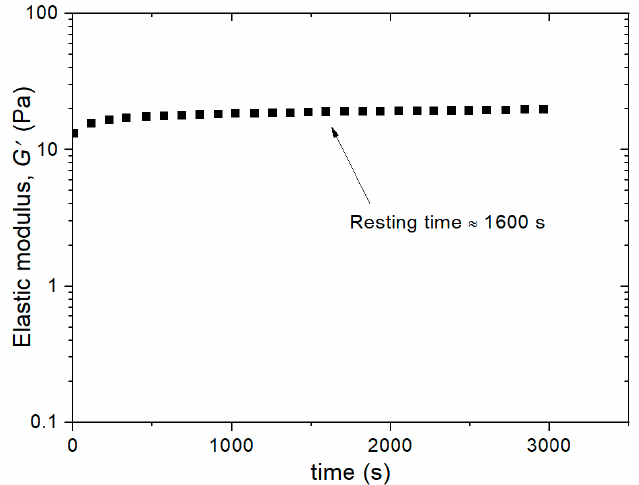
Figure 2. Structural recovery of the suspension at rest after pre-shearing. Oscillatory test at low strain (0.5%) and a frequency of 1.0 Hz.